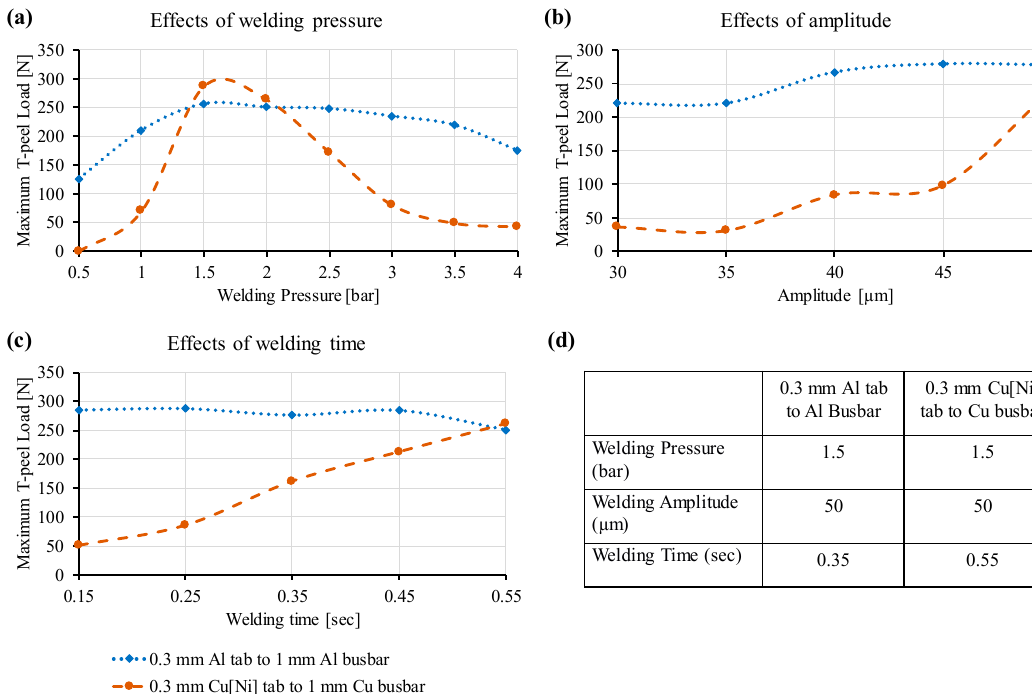
Figure 3. Maximum T-peel load obtained from ( a ) welding pressure variation; ( b ) amplitude variation; ( c ) welding time variation; and ( d ) parameters selected for producing samples for electrical and thermal characterisation.